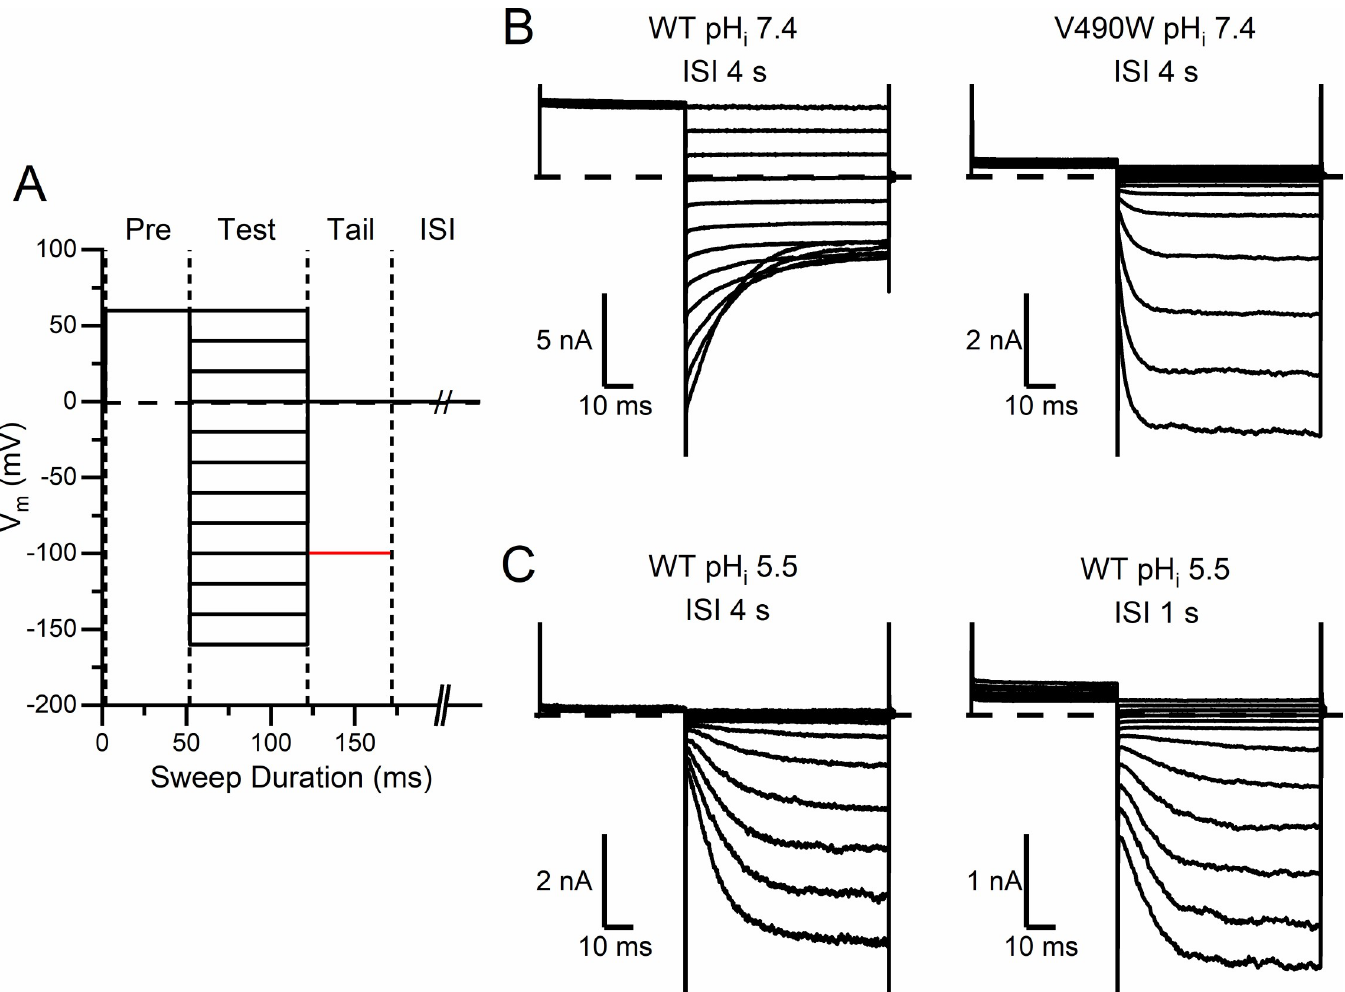
Fig 2. Voltage dependence of current activation of WT and mutant CLC-0. (A) Voltage protocol (protocol I) for recordings. A full protocol consists of 12 recording sweeps. One sweep includes a prepulse voltage step at +60 mV (50 ms) followed by one of the various test voltage steps (70 ms) from +60 mV to -160 mV in -20 mV voltage steps, and followed by a tail voltage step of 50 ms at 0 mV (colored in black) or -100 mV (colored in red). Vertical dashed lines are used to mark the switch of the voltage steps (for example, between prepulse voltage step and the test voltage step, etc.). The voltage of the inter-sweep interval (ISI) was 0 mV and the duration was 1 or 4 sec. (B) Activation of WT CLC-0 and V490W mutant at pH i = 7.4, using the voltage protocol shown in A. ISI was 4 sec. Dash line: zero-current level. Notice the inverted voltage-dependent activation in the mutant. (C) Activation of WT CLC-0 at pH i = 5.5. ISI’s are 4 and 1 sec for the recording on the left and right, respectively. Notice the inverted voltage activation of WT CLC-0 in low pH i